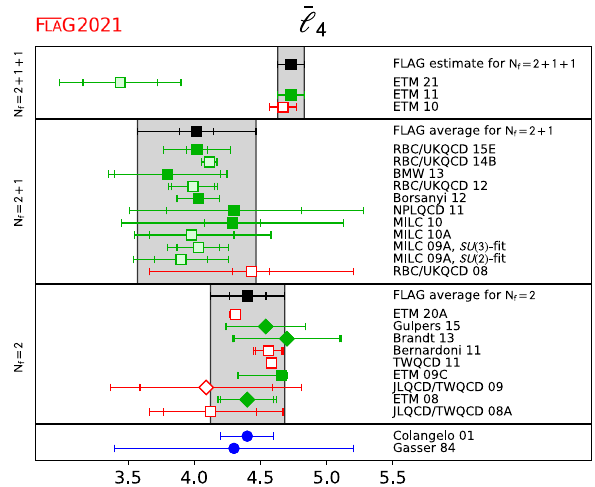
Fig. 16 Effective coupling constant ¯ (cid:6) 4 . Squares indicate determinations from correlators in the p -regime, diamonds refer to determinations from the pion form factor Table 24 Vector form factor of the pion: Lattice results for the charge radius (cid:17) r 2 (cid:18) π experimental value, as obtained by NA7, and some phenomenological estimates. The publication status of χ QCD 20 [376] changed from “preprint” to “accepted” after our closing